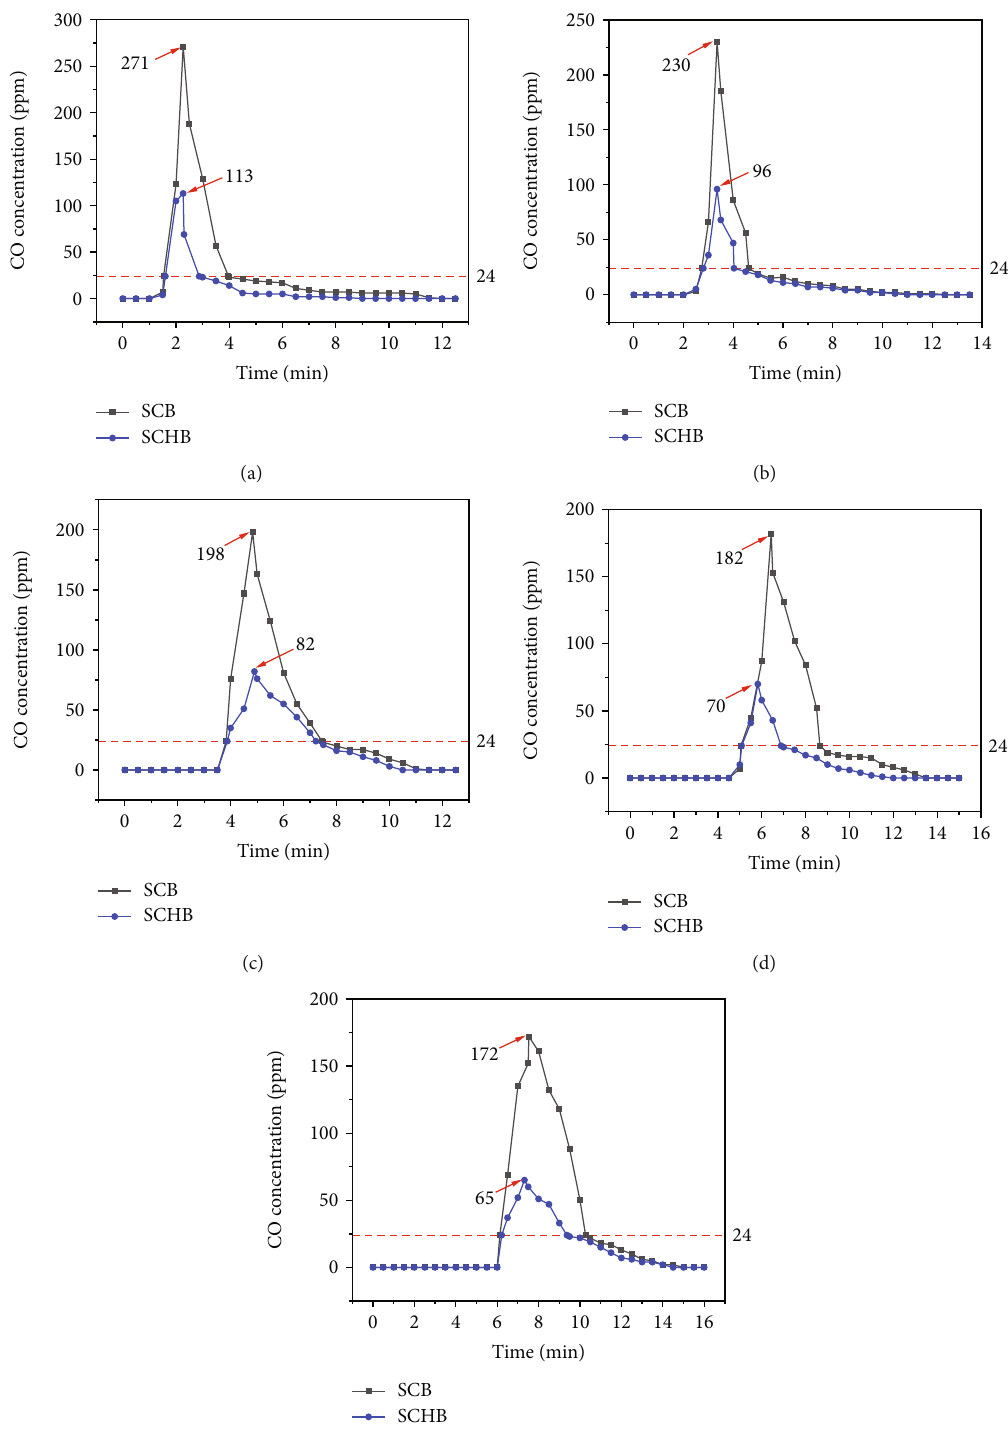
Figure 15: Time-varying curve of CO concentration in double-hole blasting at di ff erent measuring points: (a) 100 m from blasting zone, (b) 200m from blasting zone, (c) 300 m from blasting zone, (d) 400m from blasting zone, and (f) 500m from blasting